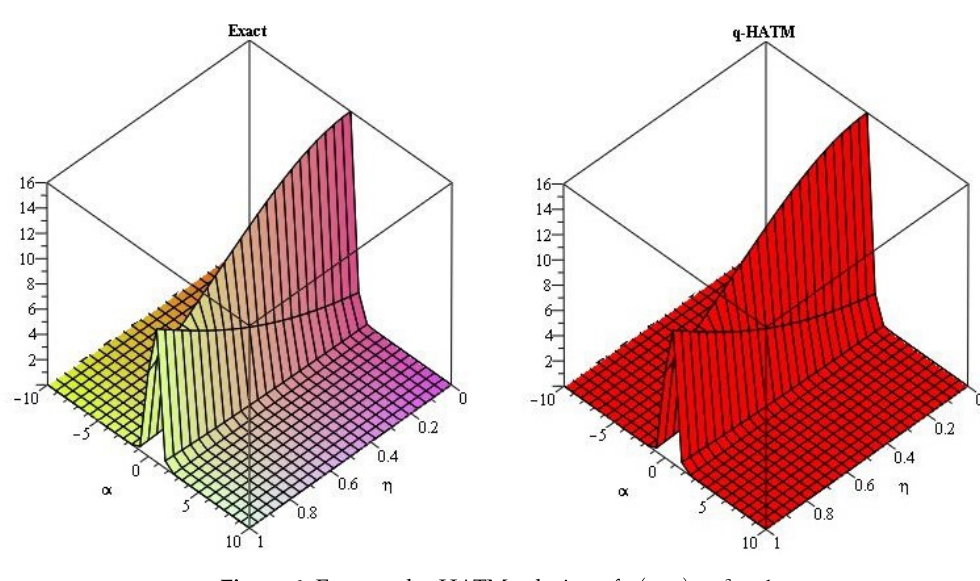
Figure 6. Exact and q-HATM solution of ν ( α , η ) at δ =